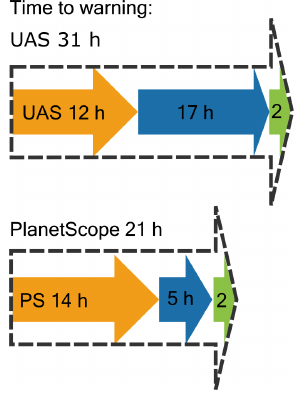
Figure 7. Time to warning is composed of three phases: time to collect, to process and to deliver. Time to warning (subsequent to acceleration) is 21h for PlanetScope and 31h for the UAS. Thus, any hazard process that takes longer than 21/31h to prepare the re- lease and impact can be